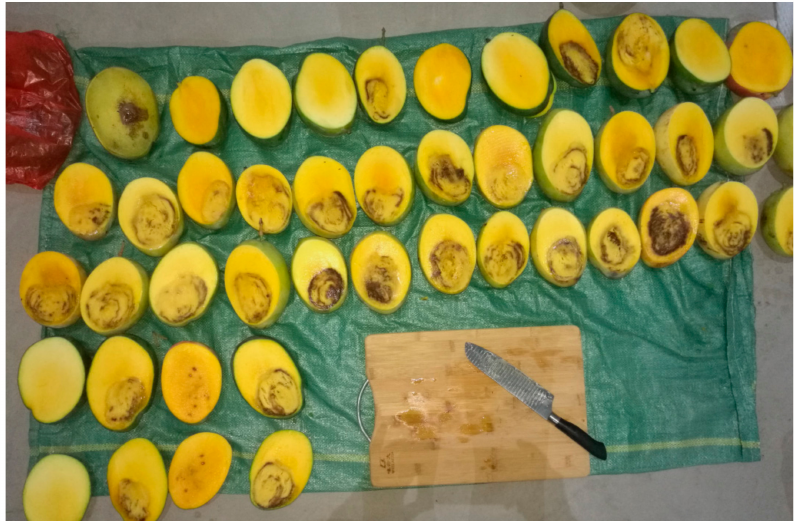
Figure 2. Phenotypical IFB symptoms in mango ‘Keitt’